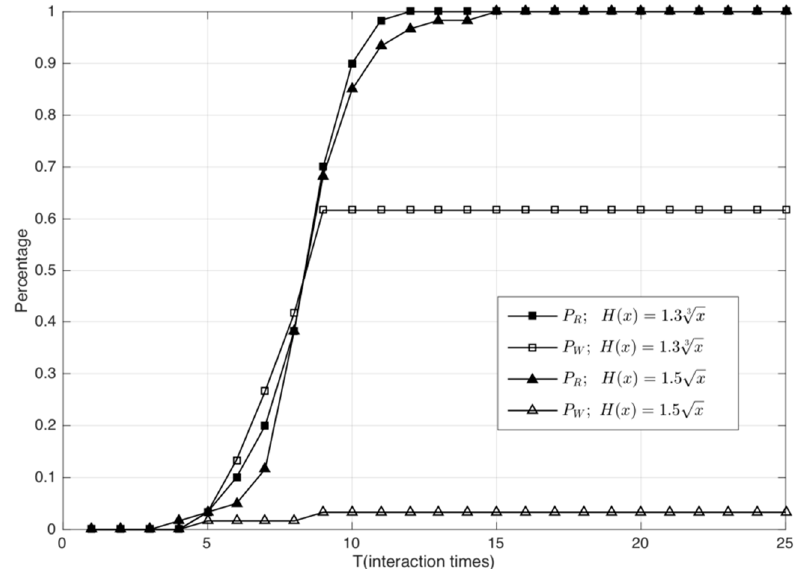
√ √ x and 1.3 3 x in hybrid attacks.